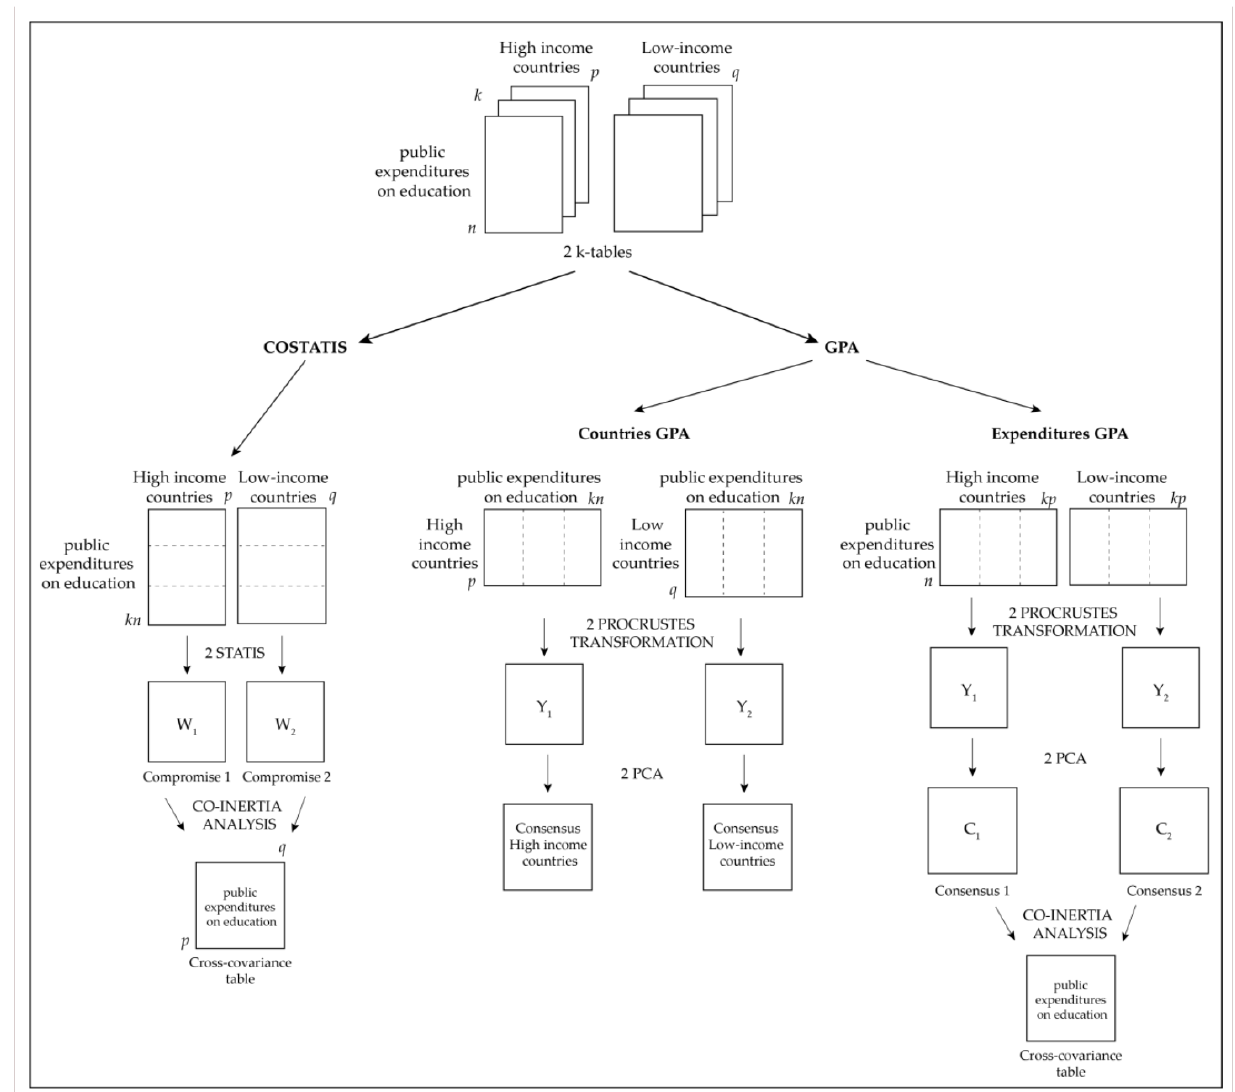
Figure 2. Presentation of the COSTATIS ( left ) and GPA ( right )